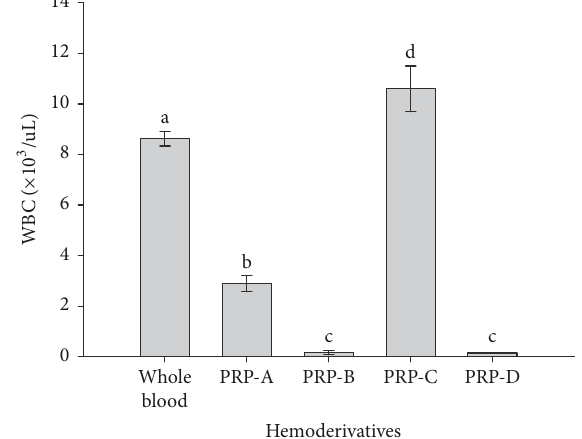
Figure 3: Mean ( ± SD) of white blood cell (WBC) concentration ( × 10 3 / 𝜇 L) in whole blood and four bovine PRP fractions (A, B, C, and D). a–d: different lowercase letters denote significant differences by the Tukey test ( 𝑝 = 0.001